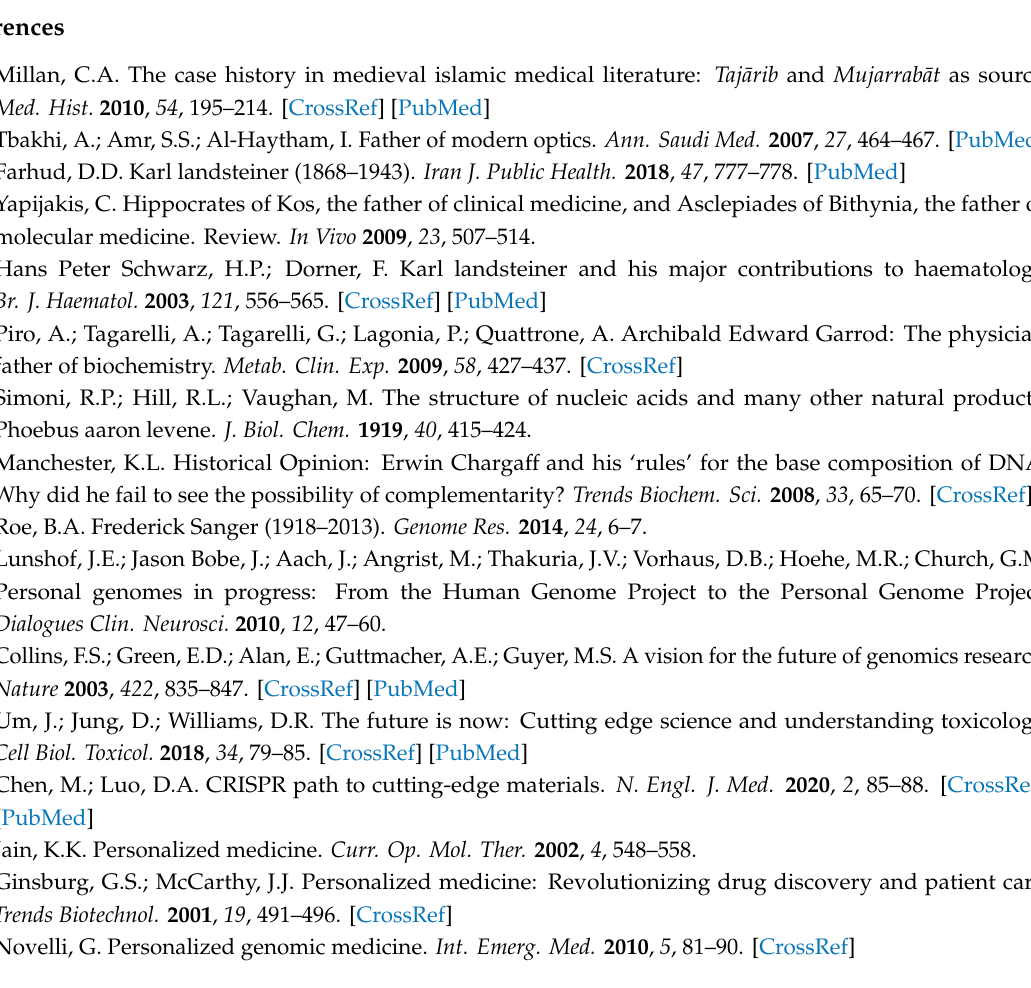
Figure A2. The complexity of cellular function involving associated omics technologies such as genomics; transcriptomics; proteomics and metabolomics. (adapted from [45]).